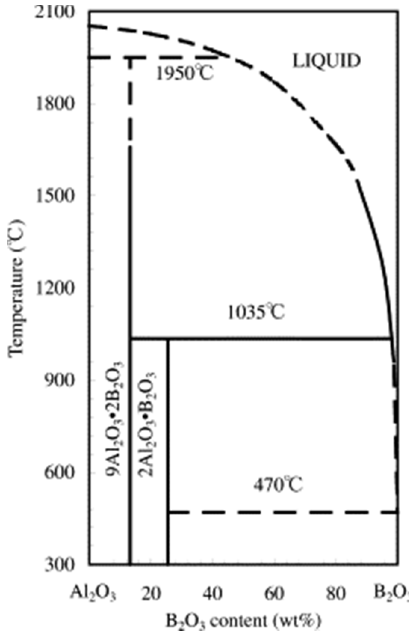
Figure 1. B 2 O 3 -Al 2 O 3 phase diagram [31] .